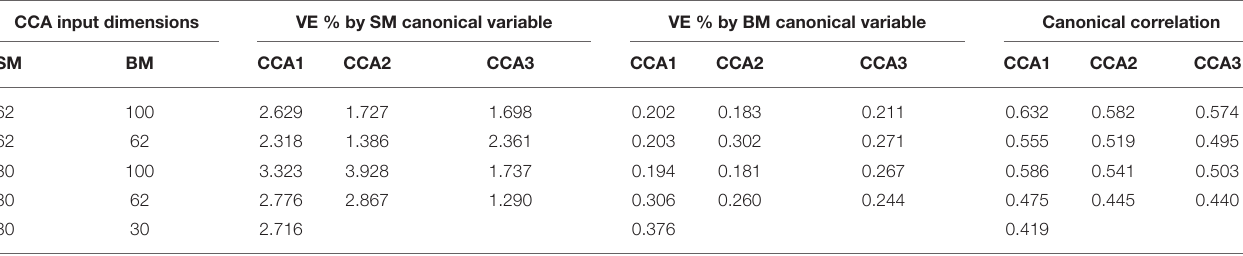
TABLE 3 | Summary table for DDR